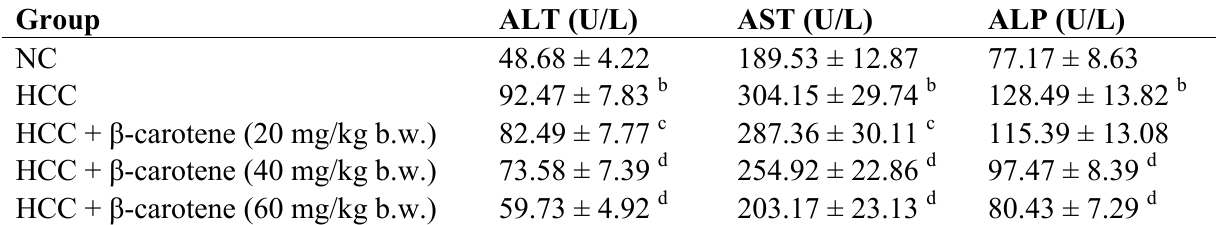
Table 4. Effect of β -carotene on blood ALT, AST and ALP in